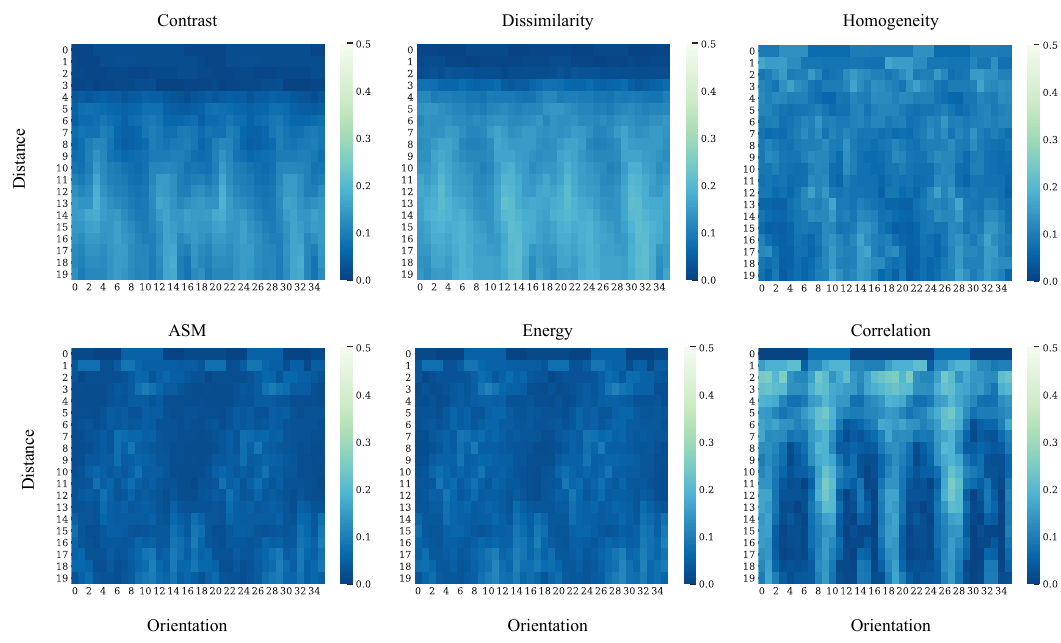
Figure 6. Heat map of optimization results of Distance and Orientation with different texture features.